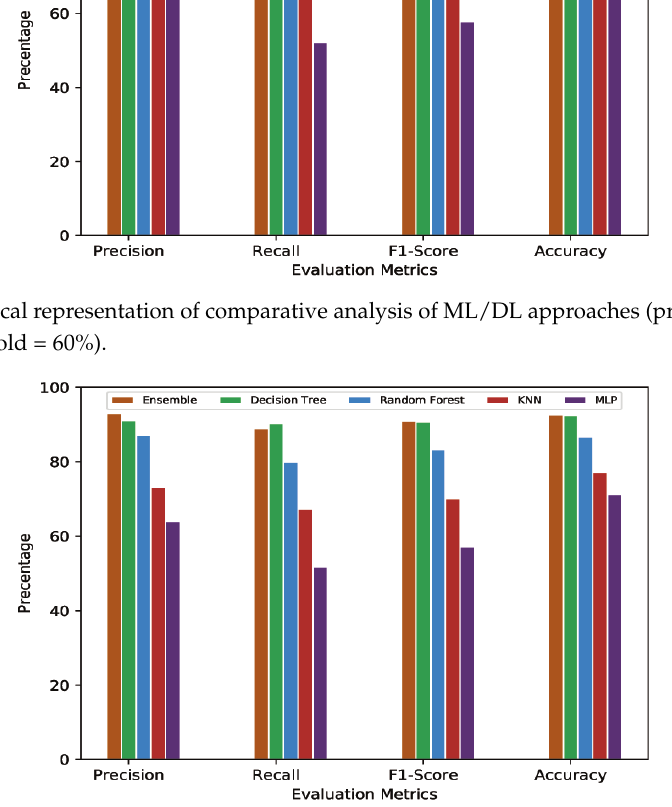
Figure 5. Graphical representation of comparative analysis of ML/DL approaches (prediction validity = 10 min, threshold = 80%).